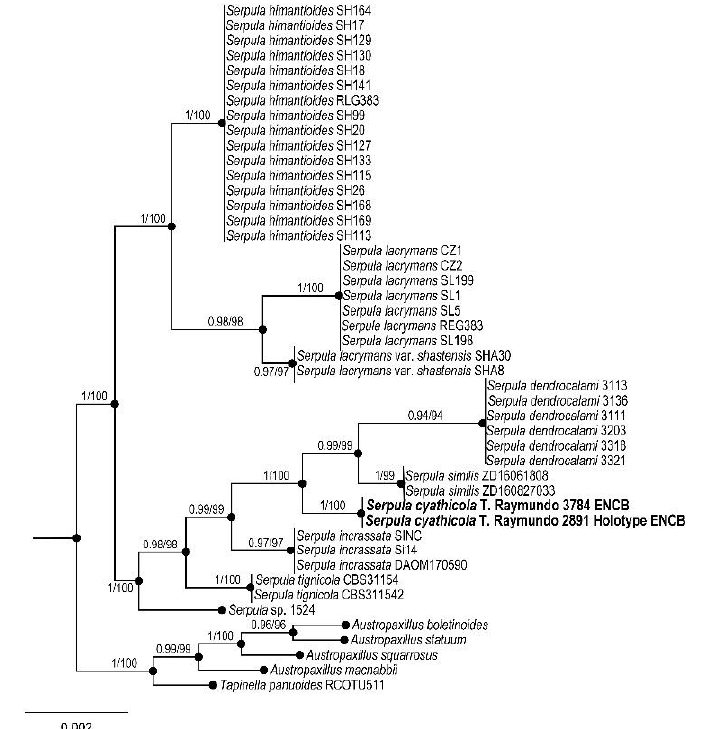
Figure 6. Bayesian inference phylogram of ITS sequences data. Posterior probability ( left of slash) from Bayesian analysis and Bootstrap support ( right of slash). The new species Serpula cyatheicola is shown in bold. Boldface names represent samples sequenced for this study.